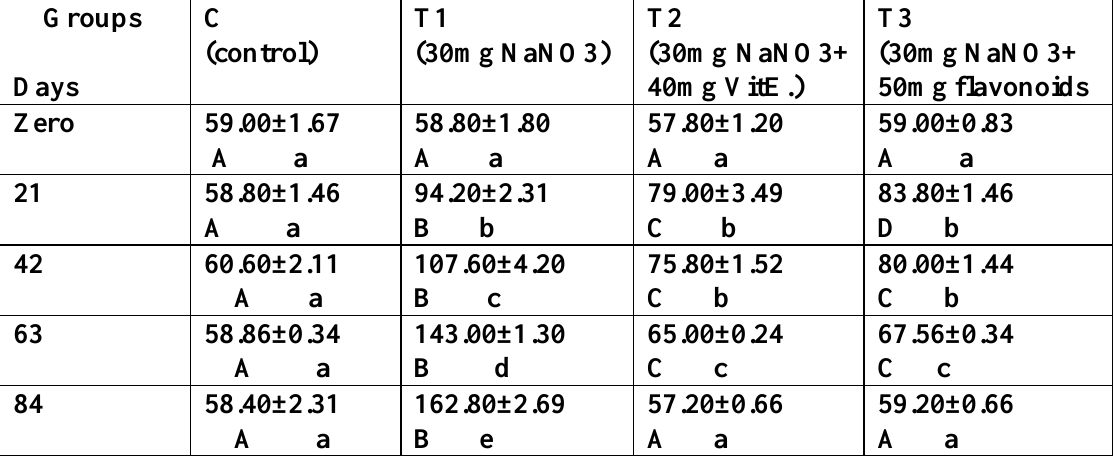
Table (2): Effect of sodium nitrate and vitamin E and flavonoids extracted from Nigella